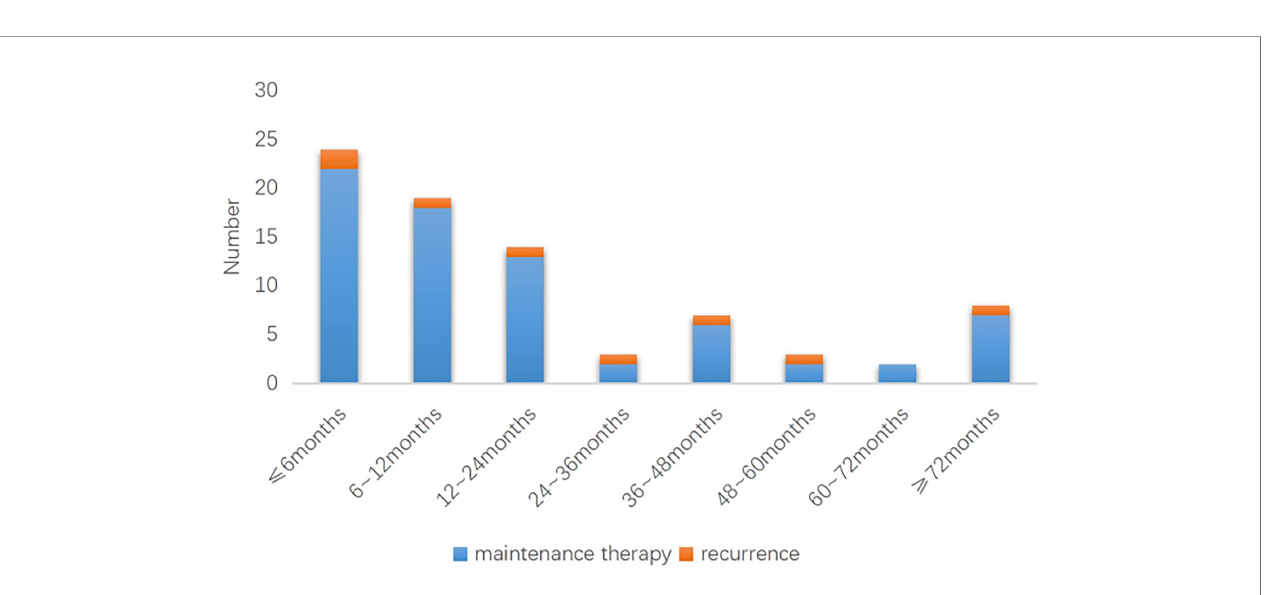
FIGURE 3 | Recurrences occurred at different period in group 2 (n=26).